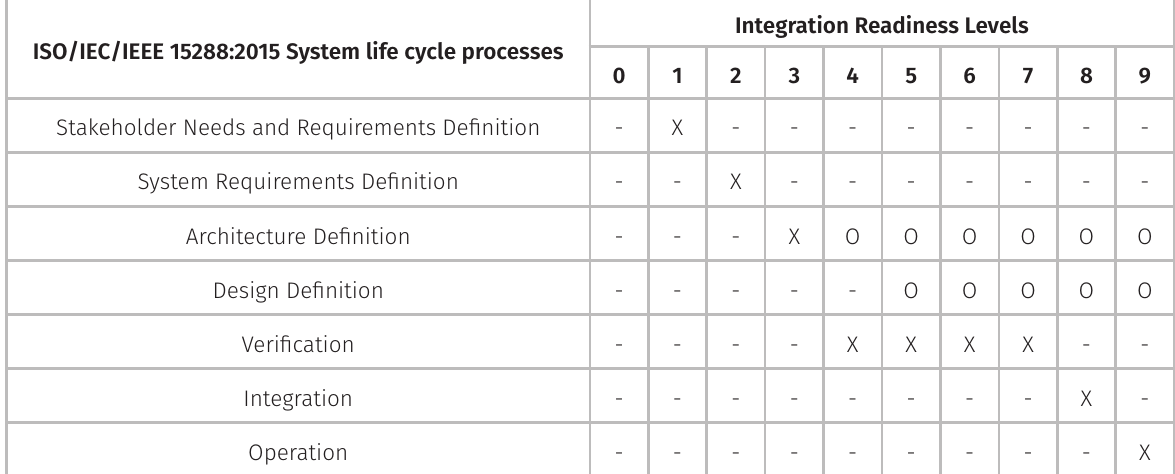
Table II. System life cycle processes selected for each Integration Readiness Level.